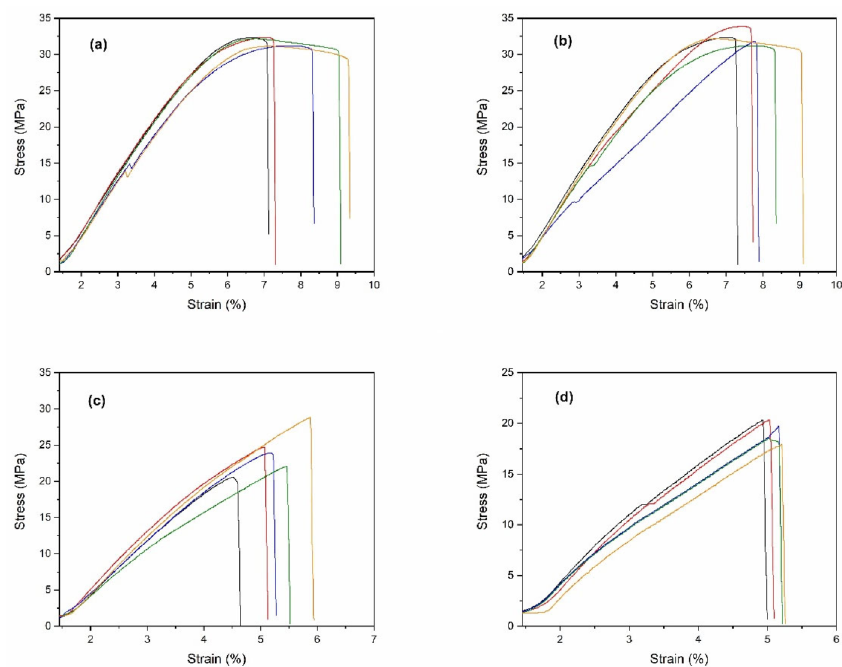
Figure 6. Stress-strain curves of: ( a ) neat PLA, ( b ) PLA/ZnO-1, ( c ) PLA/ZnO-3, and ( d ) PLA/ZnO-5, respectively. Each curve indicates the sample number.